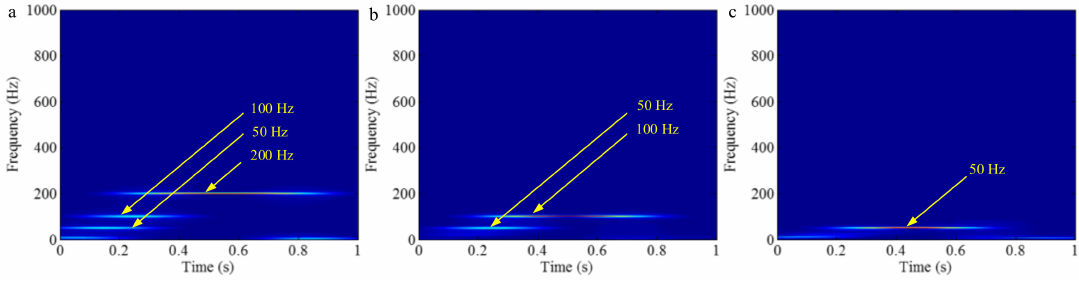
Figure 12. The STFT representations of the IMFs 1–3: ( a ) IMF 1; ( b ) IMF 2 and ( c ) IMF